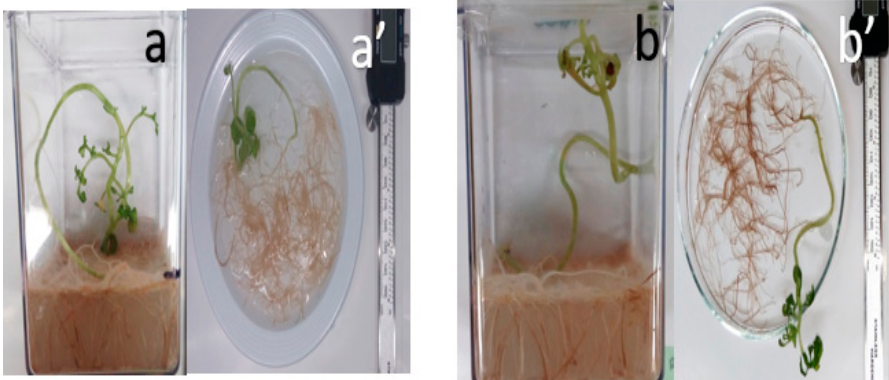
Figure 5. Tomato root plant in Magenta Vessel culture ( a , b ) control and exposed to TiO 2 NPs at 21 days and their root length respectively ( a ’, b ’). The cells’ microstructure of the tomato root samples characterized by LM in three zones, Ep, Pa and Vb (Figure 6).